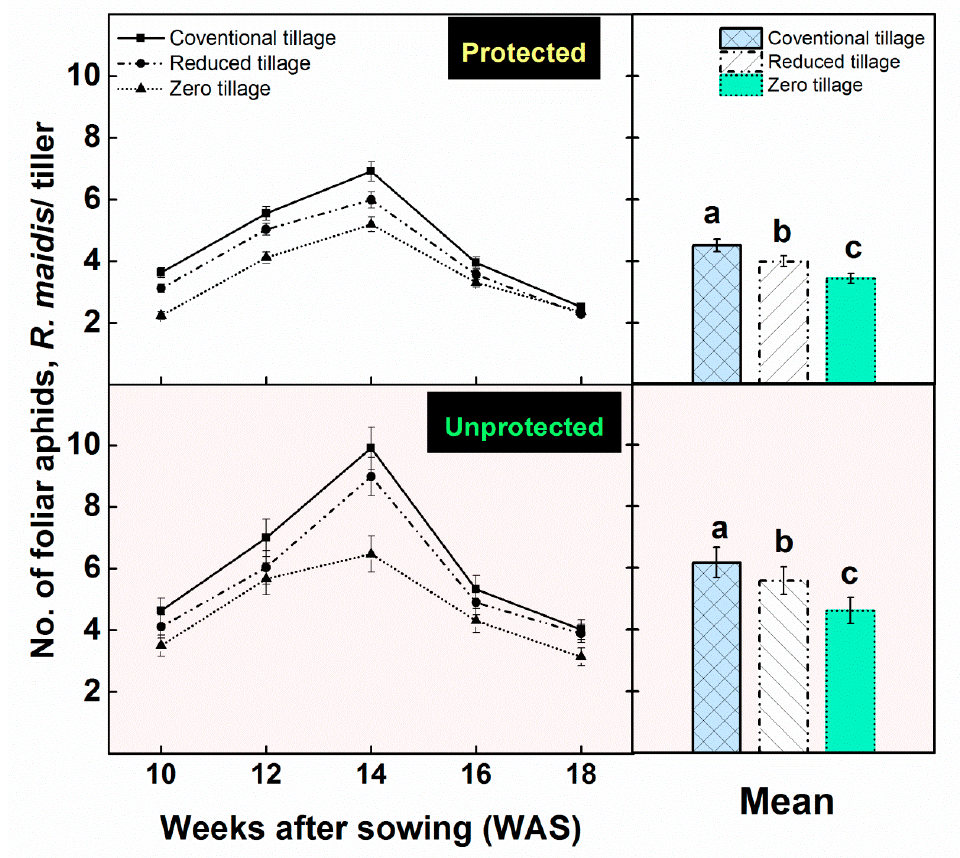
Figure 3. Foliar aphid, Rhopalosiphum maidis (Fitch) (aphids/tiller) in wheat grown under 3 tillage practices during 2016–2017 and 2017–2018 (pooled). Bars with same letters are not significantly different at p < 0.05. Error bars denote ±1 SE. Table 2. Split-plot ANOVA for foliar aphids (per tiller), root aphid (per tiller), termite damage (%), and pink stem borer damage with tillage, insecticide protection, and time of observation as factors during 2016–2017 and 2017–2018 (pooled) (significance: p ≤ 0.05 are